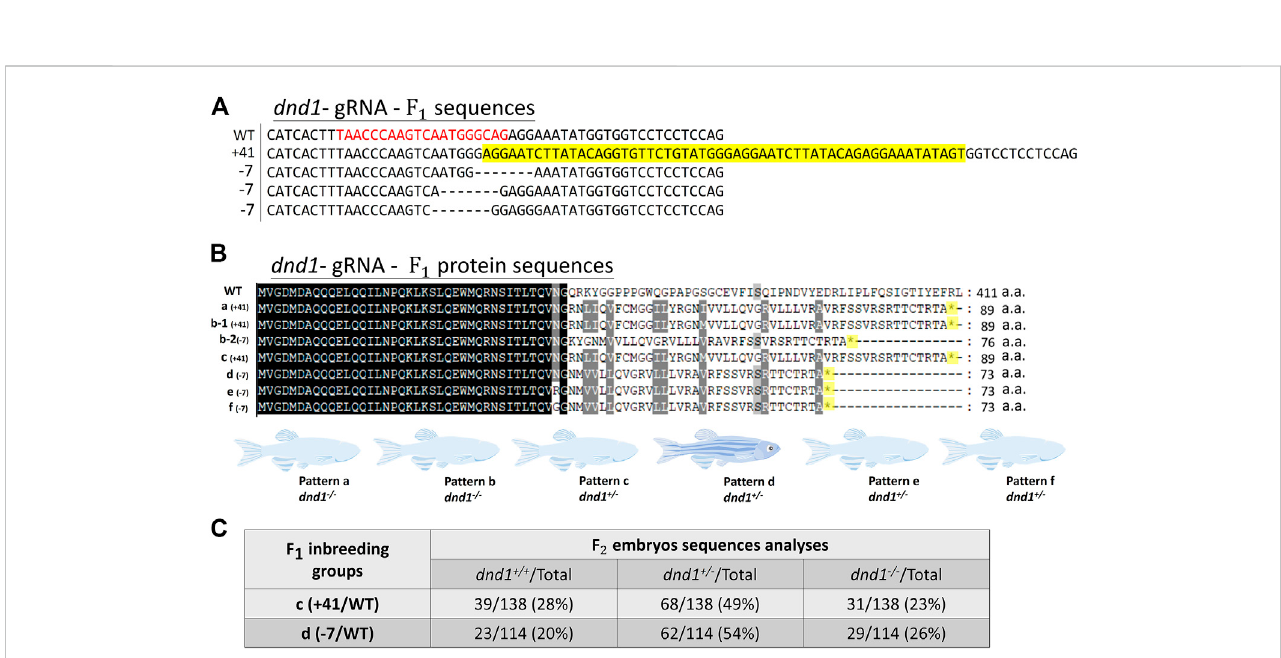
FIGURE 2 (A) Mutation sequences identi fi ed in the F 1 generation by sequencing. The analyzed individuals are shown in order of the mutation sequence size of the insertions (+)/deletions ( − ). The target site of gRNA is indicated by red characters, and the yellow highlighted sequences are insertional sequences. (B) Mutation aminoacidsequencesidenti fi edineachF 1 zebra fi shbygenotyping.Thein-framestopcodonisshownas*andhighlightedinyellow. (C) Analysis of the ratio of different genotypes in F 2